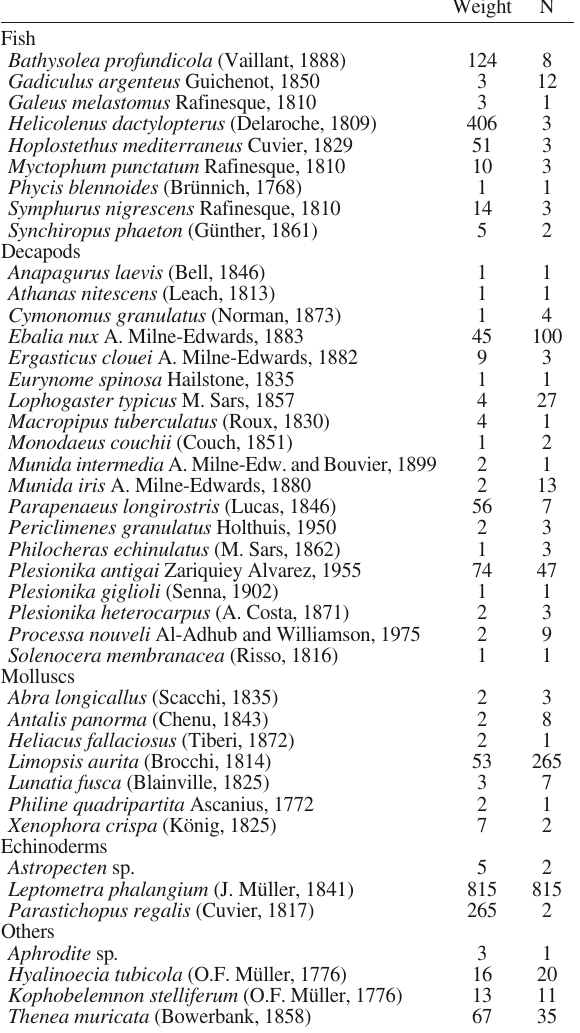
Table 1. – Shipboard faunal list of haul BT04 with notes on biomass (Weight, g) and abundance (N, number of individuals or colonies) of each species. These figures relate to a sampled area of 889 m 2